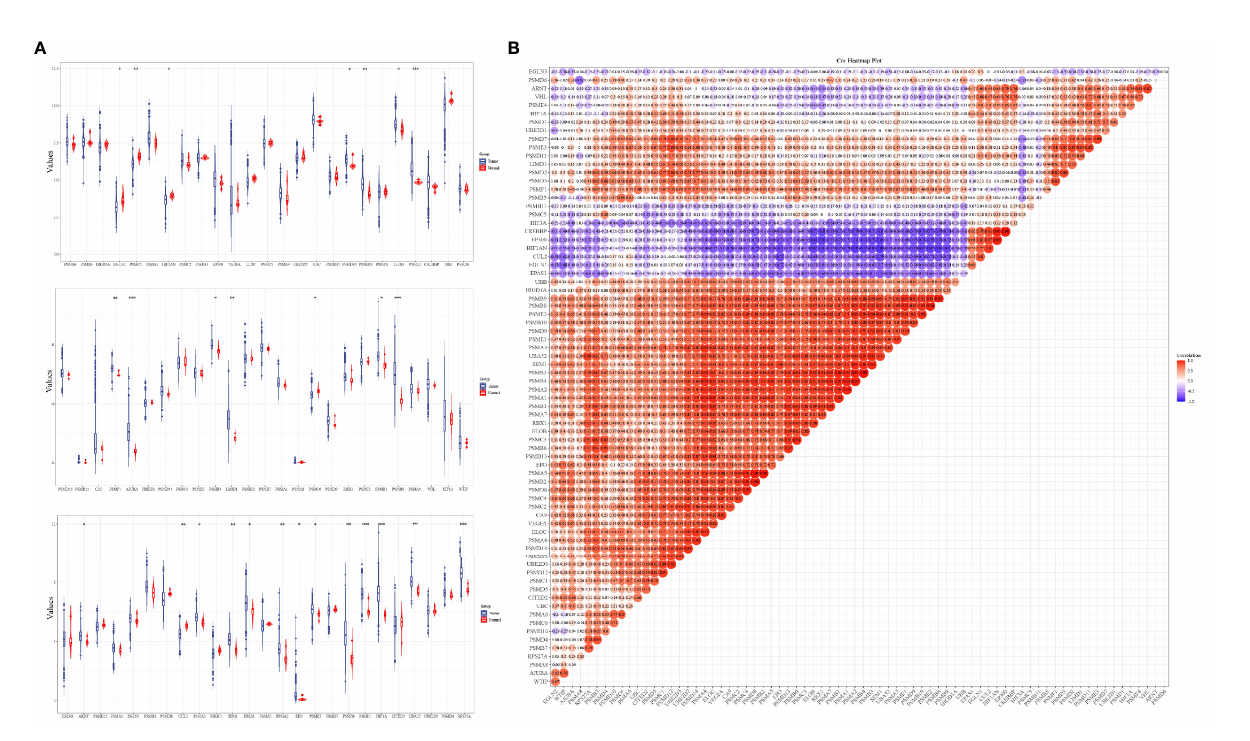
FIGURE 1 | Expression levels and correlations of hypoxia-related genes in the TCGA database. (A) Expression levels of 75 hypoxia-related genes in the TCGA database and (B) correlation of expression levels of 75 hypoxia-related genes in the TCGA database glioma samples. *p < 0.05, **p < 0.01, ***p <